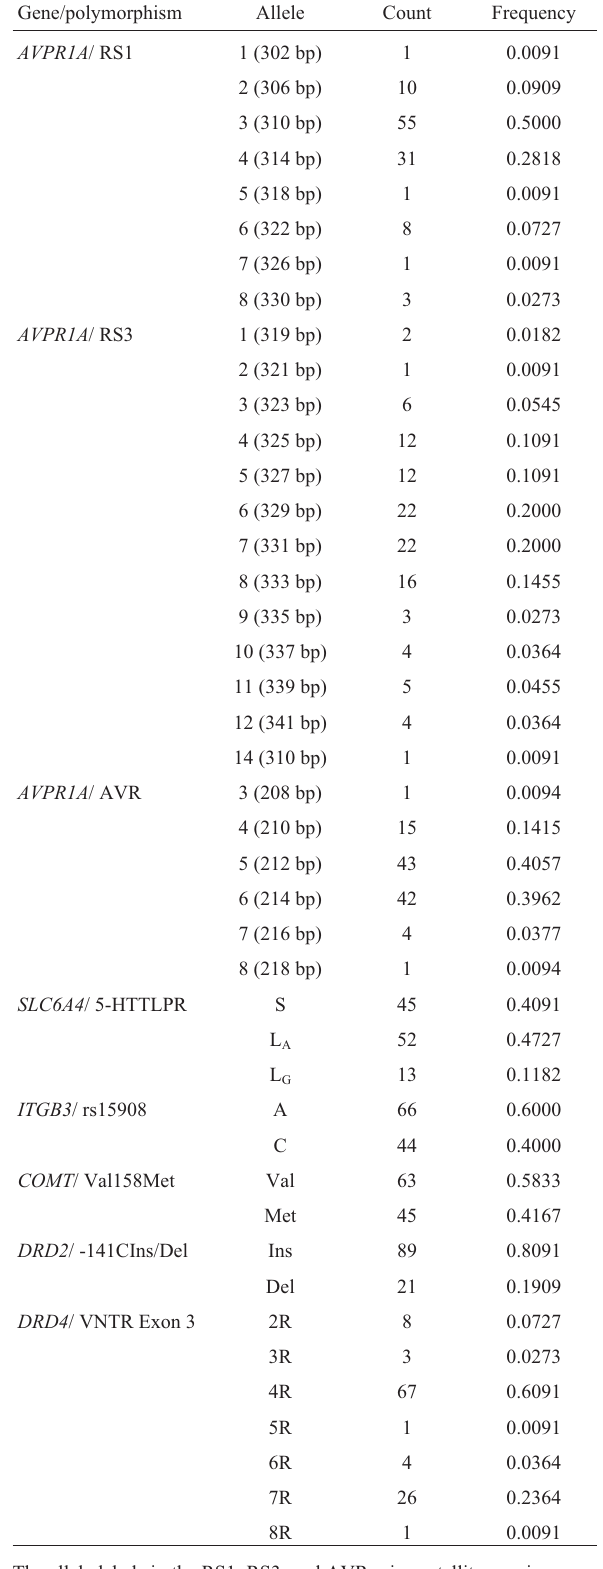
Table 1 - Allele frequency of the polymorphisms analyzed in this study.